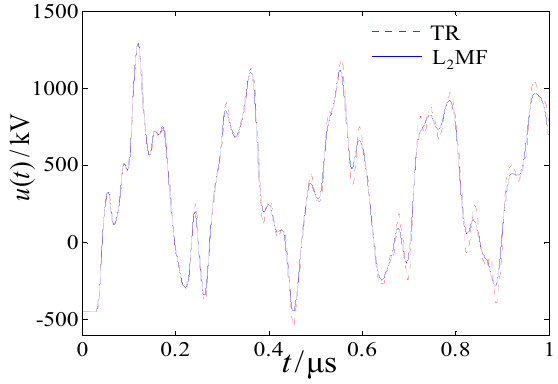
Figure 11. VFTO calculated by the four-step L 2 MF method and the TR method.